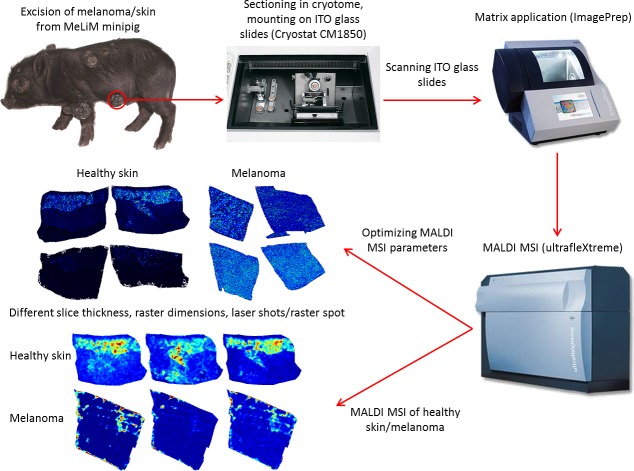
Schematic of MALDI MSI of MeLiM healthy skin/melanoma tissue.